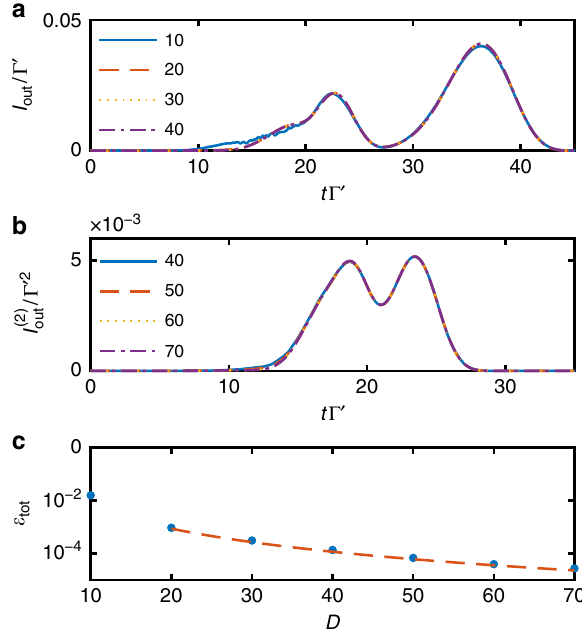
Fig. 7 Convergence of VIT observables. a Intensity and b zero-delay second-order correlation function for the quantum trajectory without jumps at different values of the maximum bond dimension D . c Log-scale accumulated compression error ϵ tot as function of the MPS maximum bond dimension D (blue dots). The red line is a polynomial fi t, ϵ tot / D (cid:2) 2 : 9 , for all the points except D =